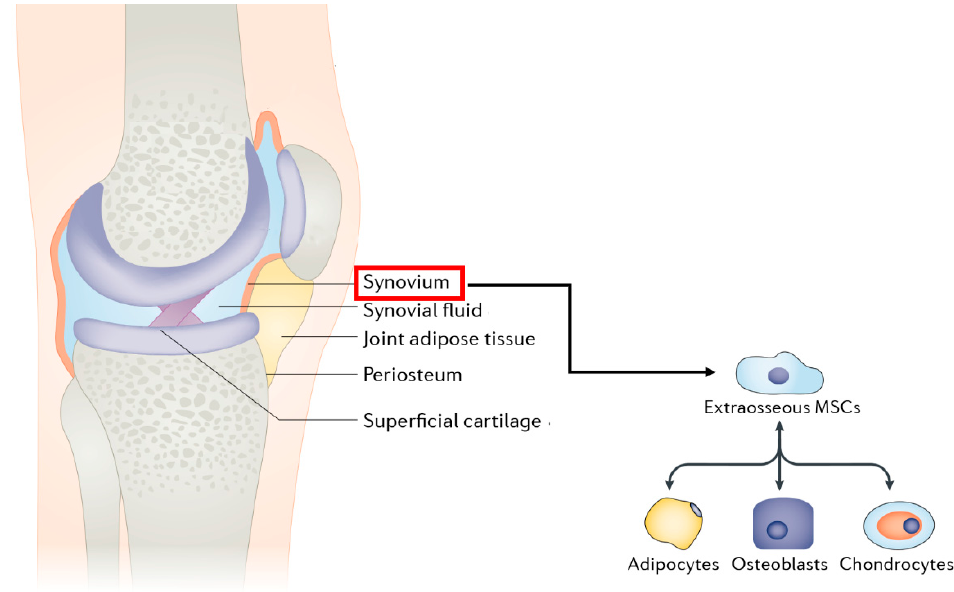
Figure 10. Representation of S-MSCs location in the knee joint and their potential in differentiation. Reproduced with some modifications from Reference [349] .